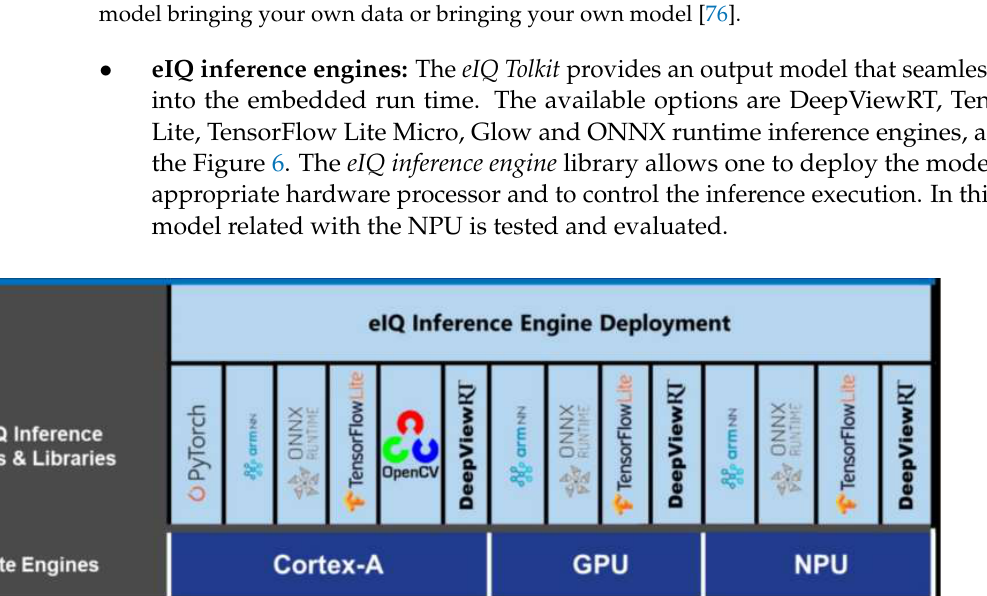
Figure 5 . eIQ block diagram presenting the tools available to develop, analyze and deploy a custom model bringing your own data or bringing your own model [76].